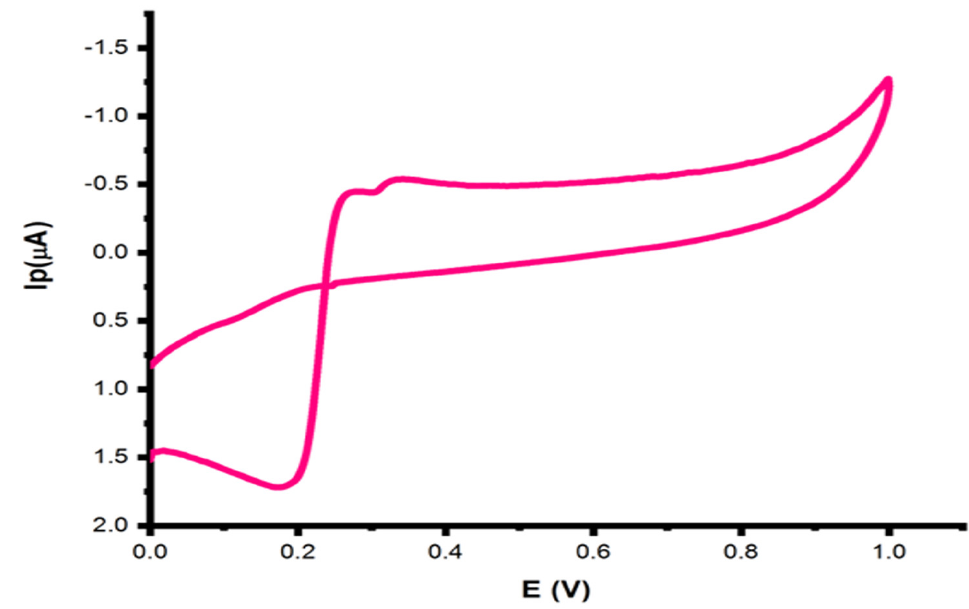
Figure 7. Cyclic voltammogram of modified xanthan gum nanoparticle electrode for Hg 2+ ions.